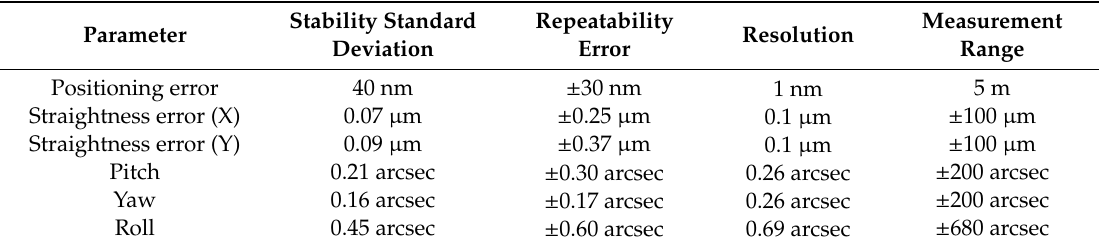
Table 2. Parameters of 6DOF motion errors measurement